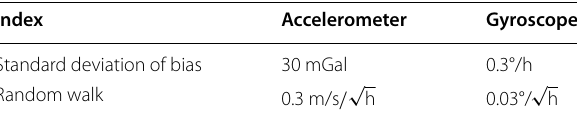
Table 3 Specification of the IMU used in the second field